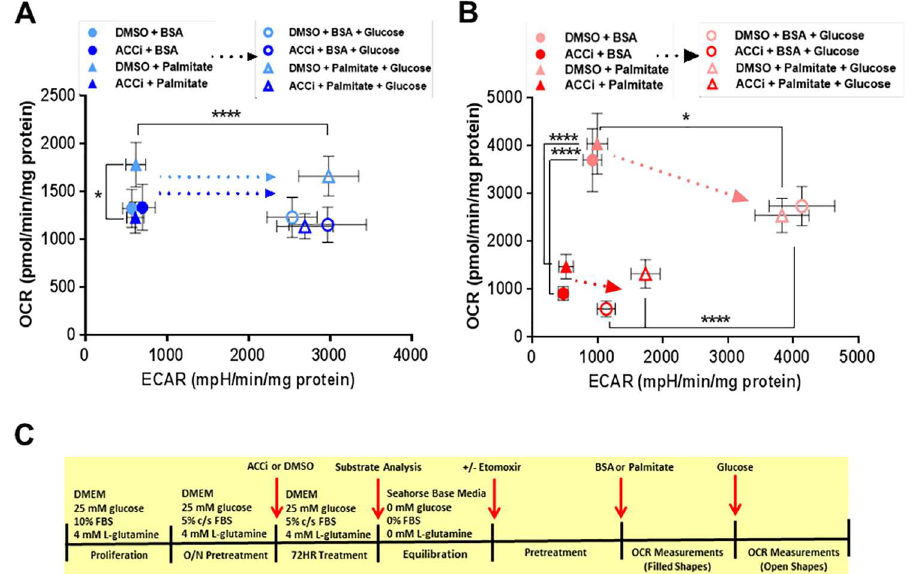
Fig 4. Inhibition of ACC alters the metabolic response of U87 and U87 EGFRvIII cells to fatty acids and glucose. (A) Oxygen ConsumptionRate (OCR) and ExtracellularAcidification Rate (ECAR) values for U87 cells after treatment with 30 μ M ACCi or DMSO control for 72 hours followedby acute treatment with BSA or 100 μ M palmitateand 10 mM glucoseas assessedby SeahorseXF96e system. Data are expressedas pmol/ min/mg protein (OCR) and mpH/min/mg protein (ECAR). Each data point representsmean +/- sem, n = 3. * p < 0.05, **** p < 0.0001. (B) Oxygen Consumption Rate (OCR) and Extracellular Acidification Rate (ECAR) values for U87 EGFRvIII cells after treatment with 30 μ M ACCi or DMSO control for 72 hours followedby acute treatment with BSA or 100 μ M palmitate and 10 mM glucoseas assessed by SeahorseXF96e system. Data are expressedas pmol/min/mg protein (OCR) and mpH/min/mg protein (ECAR). Each data point represents mean +/- sem, n = 3. * p < 0.05, **** p < 0.0001. (C) Experimental timelineand media compositions for Figs 4A and